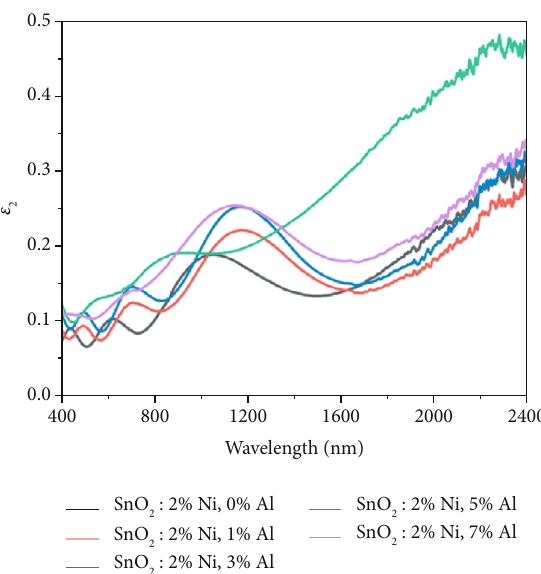
Figure 9: Evolution of the refractive index ( n ) of Al-Ni-codoped SnO thin fi lms. 2